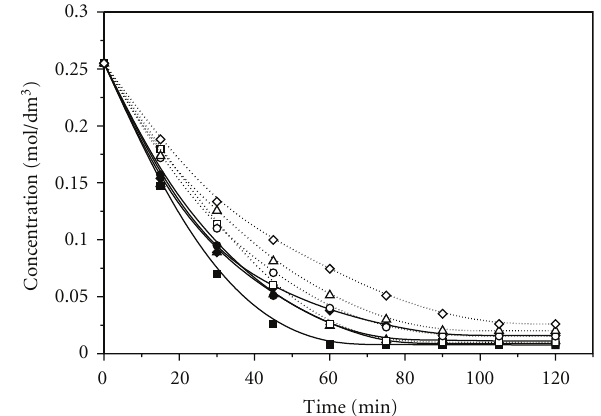
Figure 2: Change of the allicin concentration using conventional heating at 45 ◦ C and 55 ◦ C ( (cid:2) Acetonitrile 55 ◦ C; (cid:5) Acetonitrile 45 ◦ C; • Acetone 55 ◦ C; ◦ Acetone 45 ◦ C; (cid:3) Methanol 55 ◦ C; (cid:4) Methanol 45 ◦ C; (cid:4) Chloroform 55 ◦ C; ♦ Chloroform 45 ◦